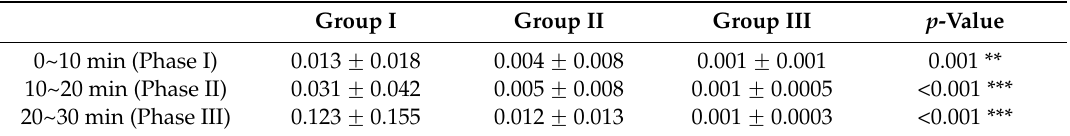
Table 2. The PSI values of the three groups with 3 different times. Data is represented as mean ˘ SD (unit is g, gravitation). Group I Group II Group